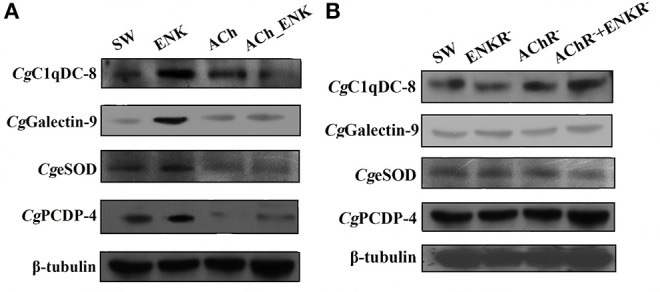
Determination of four key immune-related molecule expression. (A) The protein expression of CgC1qDC-8, CgGalectin-9, CgeSOD, and CgPCDP-4 after LPS stimulation and treatments of ACh and ENK. (B) The protein expression of CgC1qDC-8, CgGalectin-9, CgeSOD, and CgPCDP-4 after LPS stimulation and treatments of ACh and ENK when AChRs and ENKRs were blocked by antagonists.